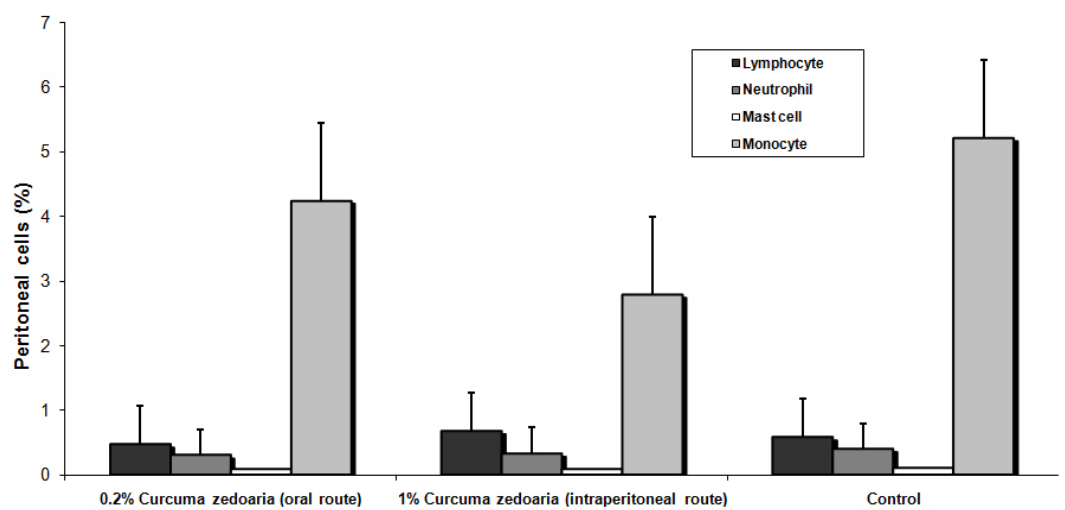
Figure 5. Differential cell migration to the peritoneal cavity. C57BL/6J mice were treated with 0.2 or 1% Curcuma zedoaria crude extract. Data are expressed as mean ±